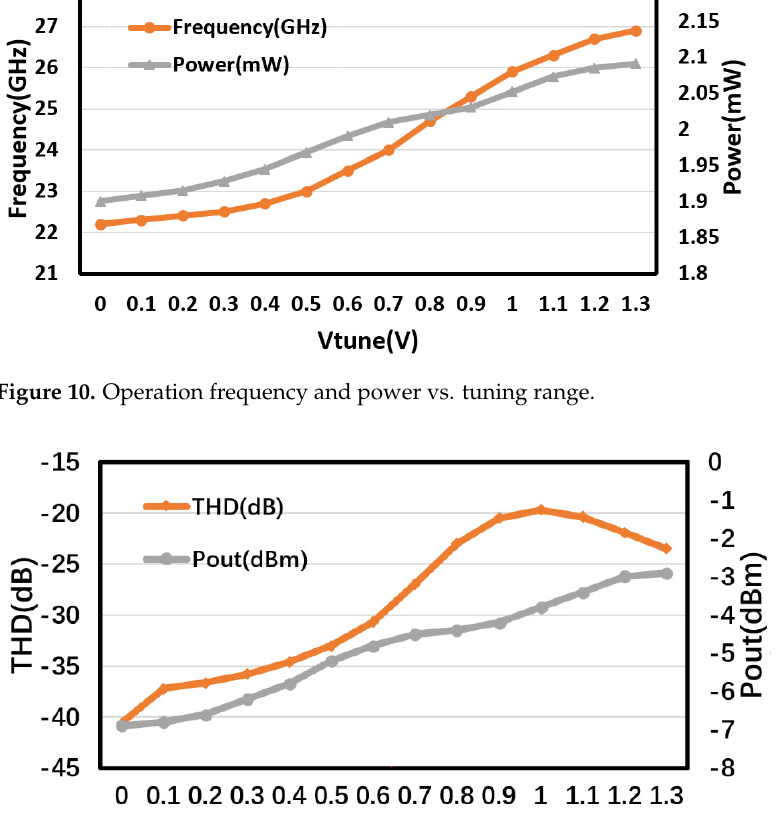
Figure 9. Post-layout simulation of VCO in minimum oscillation frequency and its spectrum.